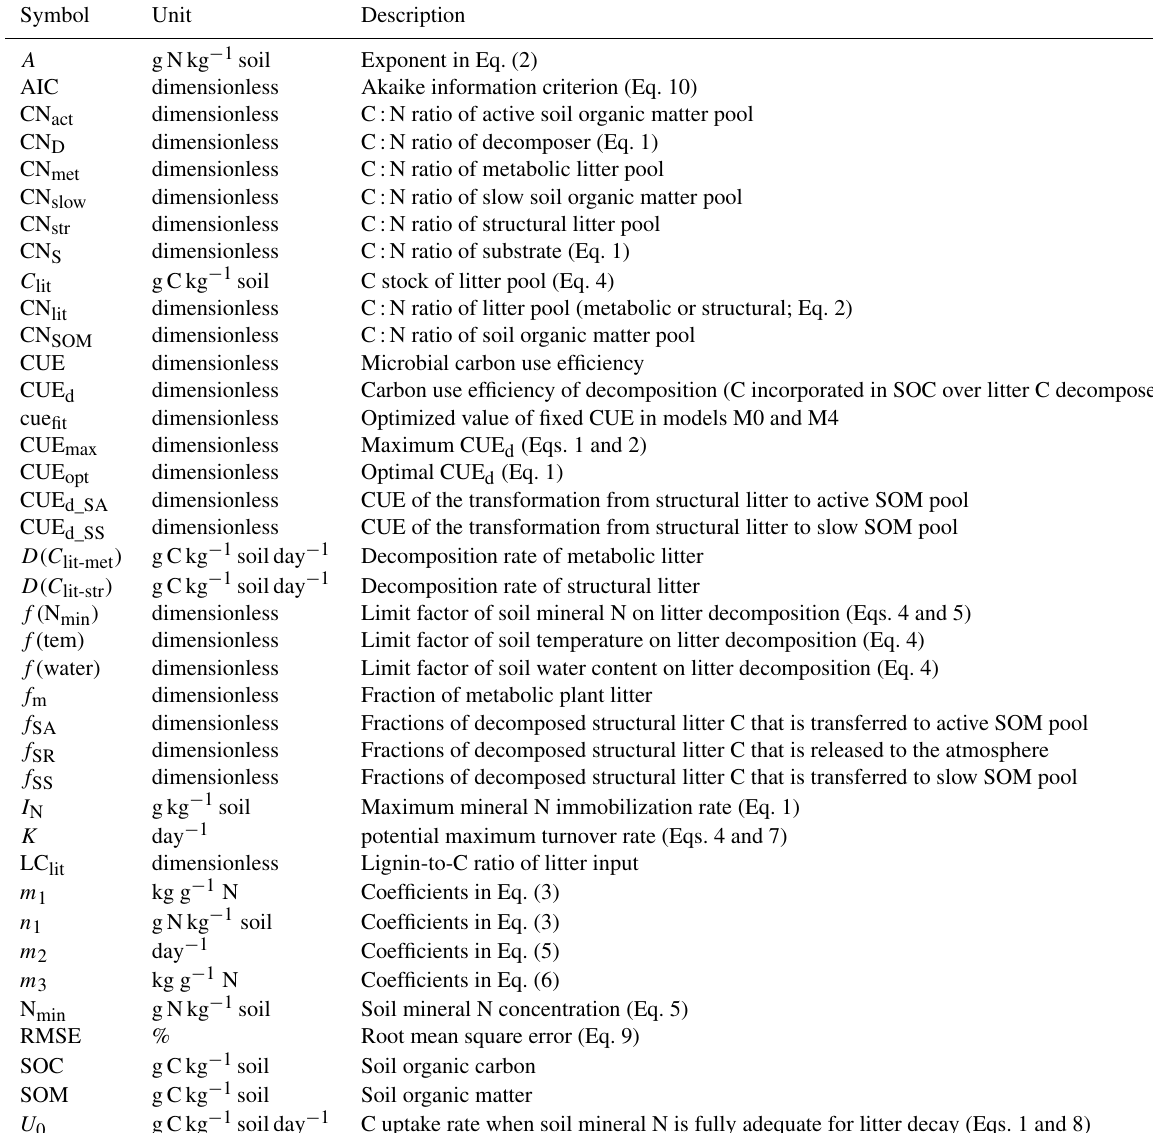
Table A1. List of symbols used in this study; stoichiometric ratios are all expressed on a mass basis. Symbol Unit Description gNkg − 1 soil Exponent in Eq. (2) dimensionless Akaike information criterion (Eq. 10) dimensionless C:N ratio of active soil organic matter pool dimensionless C:N ratio of decomposer (Eq. 1) dimensionless C:N ratio of metabolic litter pool dimensionless C:N ratio of slow soil organic matter pool C:N ratio of structural litter pool C:N ratio of substrate (Eq.